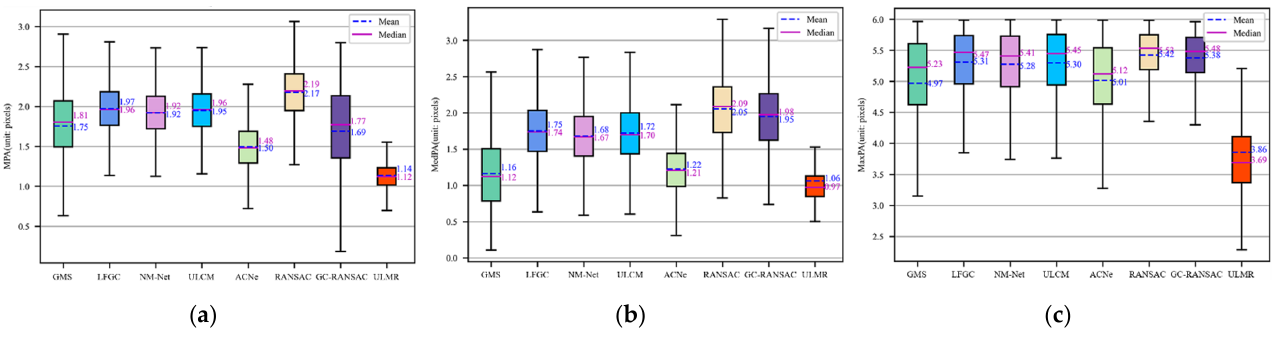
Figure 7. Box plots of positional accuracy for the remaining matches. ( a ) MPA; ( b ) MedMPA; ( c ) MaxPA. ( c )